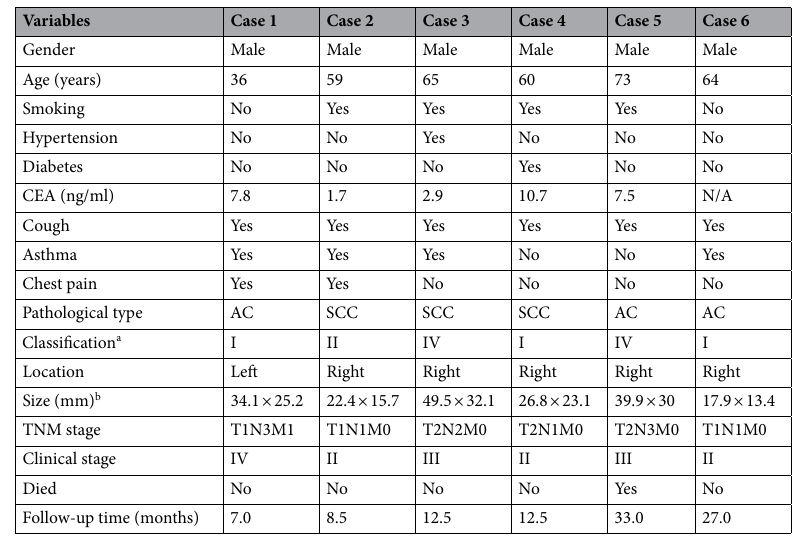
Table 1. Baseline clinical and CT findings. CEA: carcinoembryonic antigen (normal range, 0.00–5.00 ng/ml); AC: adenocarcinoma; SCS: squamous carcinoma; N/A: not available. a Represents the Mascalchi classification of cystic lung cancer. b Represents the long diameter of the lesion multiplied by the short diameter of the lesion.